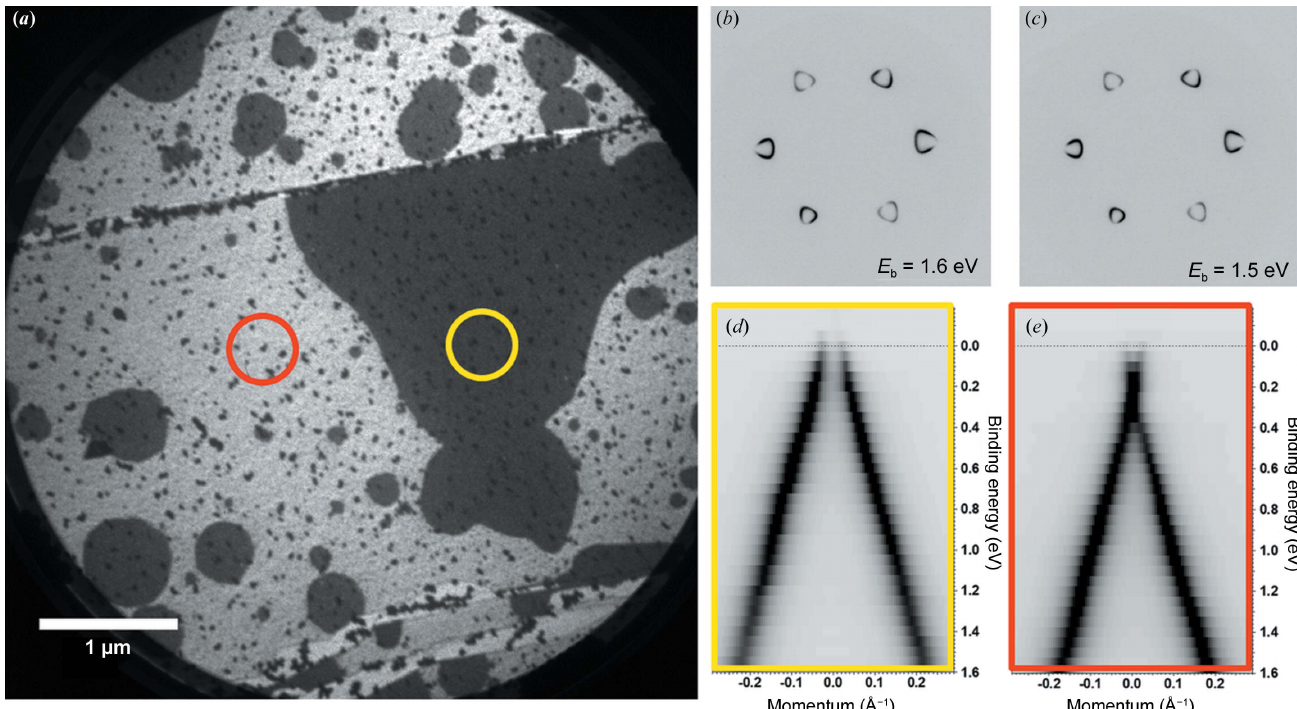
Figure 11 ( a ) LEEM image of Ge-intercalated graphene. The contrast in the image can be attibuted to different doping, black areas are p -type doped and white areas are n-type doped. On the right, selected area micro-ARPES data are shown: panels ( b ) and ( c ) are constant energy scans close to the Fermi level; panels ( d ) and ( e ) show the E ( k ) band structure (Dirac cone) from the marked areas (red and yellow) in ( a ). The sampling area is about 1.5 m m and the photon energy is 42.3